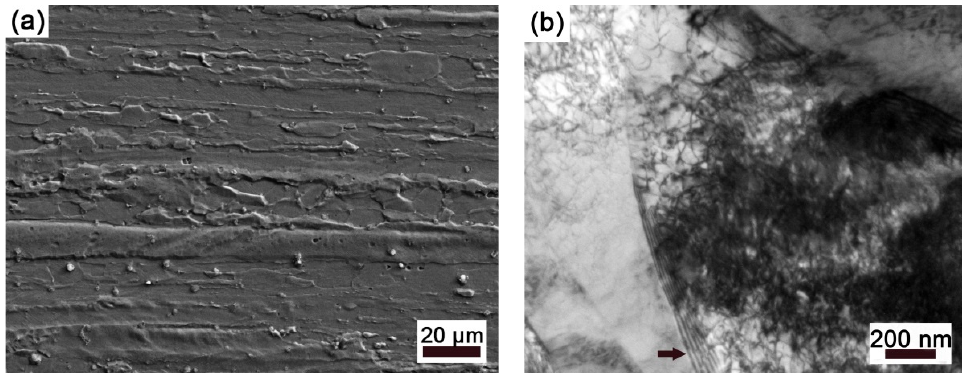
Figure 1. ( a ) SEM micrograph of microstructure and ( b ) TEM micrograph of dislocation morphology in grain for hot-drawn sample.